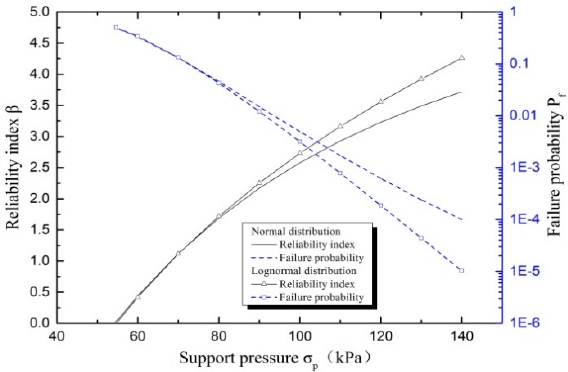
Figure 3. The effect of support pressure on reliability index and failure probability.